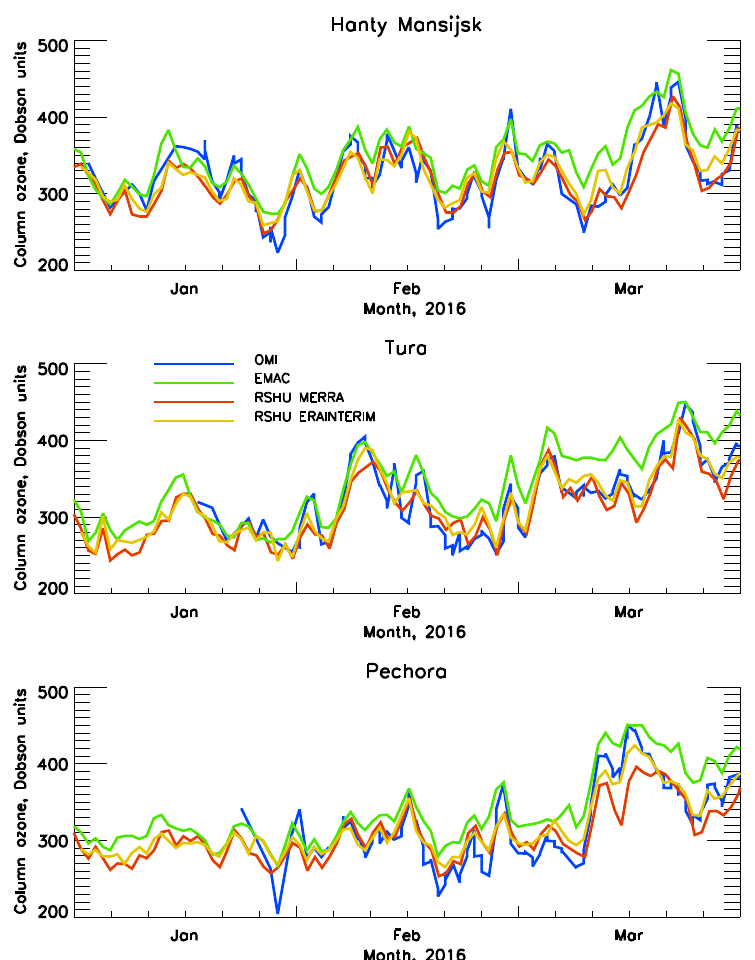
Figure 3. Total ozone measurements provided by OMI and simulation results from EMAC and the RSHU for the stations Khanty-Mansiysk, Tura, and